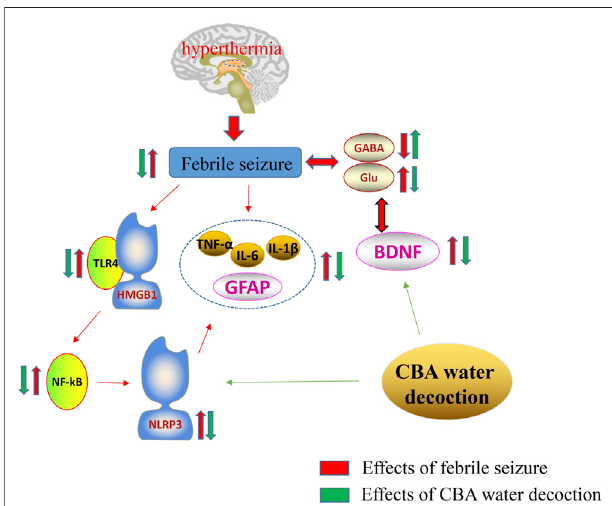
FIGURE 8 | Mechanism of the neuroprotective effect of cattle bile Arisaema (CBA) in the febrile seizure (FS) rat model. BDNF, Brain-derived neurotrophic factor; GABA, γ -aminobutyric acid; GFAP, Glial fi brillary acidic protein; Glu, Glutamic acid; HMGB-1, Human high-mobility group box- 1; IL-1 β , Interleukin-1 β ; IL-6, Interleukin-6; NF- κ B, Nuclear transcription factor-kappa B; NLRP3, Nucleotide-binding oligomerization domain- (Nol-) likereceptor family pyrindomain containing3;TLR4,Toll-likereceptor 4;TNF- α , Tumor necrosis factor α .